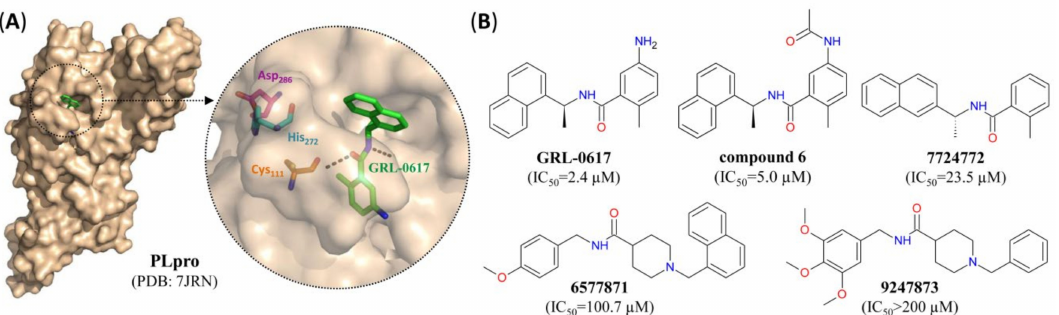
Figure 8. SARS-CoV-2 PLpro small molecule non-covalent inhibitors. ( A ) Surface representation of the crystal structure of PLpro from SARS-CoV-2 with GRL-0617 (green) bound to the active site. Inset: close-up view of the inhibitor-bound active site, with residues forming the catalytic triad indicated in turquoise (His 272 ), orange (Cys 111 ) or purple (Asp 286 ) and hydrogen bonds indicated by dashed black lines. ( B ) Structure of di ff erent small molecule non-covalent SARS-CoV-2 PLpro inhibitors. For pharmacological properties, see Table